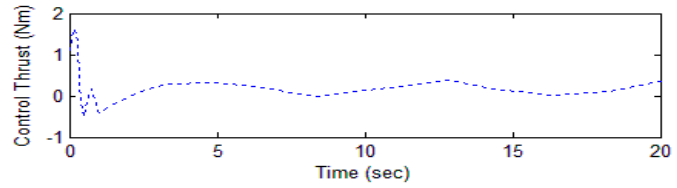
Figure 7. Control thrust of an Unmanned Aerial Vehicle (UAV) without noise or disturbance.